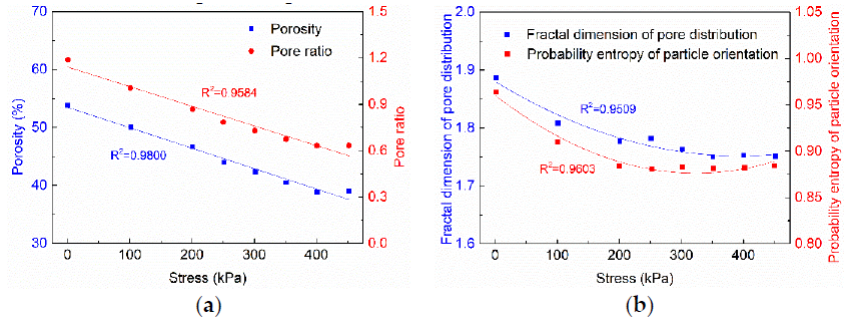
Figure 8. Meso-structure-stress evolution model of soft marine soil: ( a ) porosity and pore ratio; ( b ) fractal dimension of pore distribution and probability entropy of particle orientation.